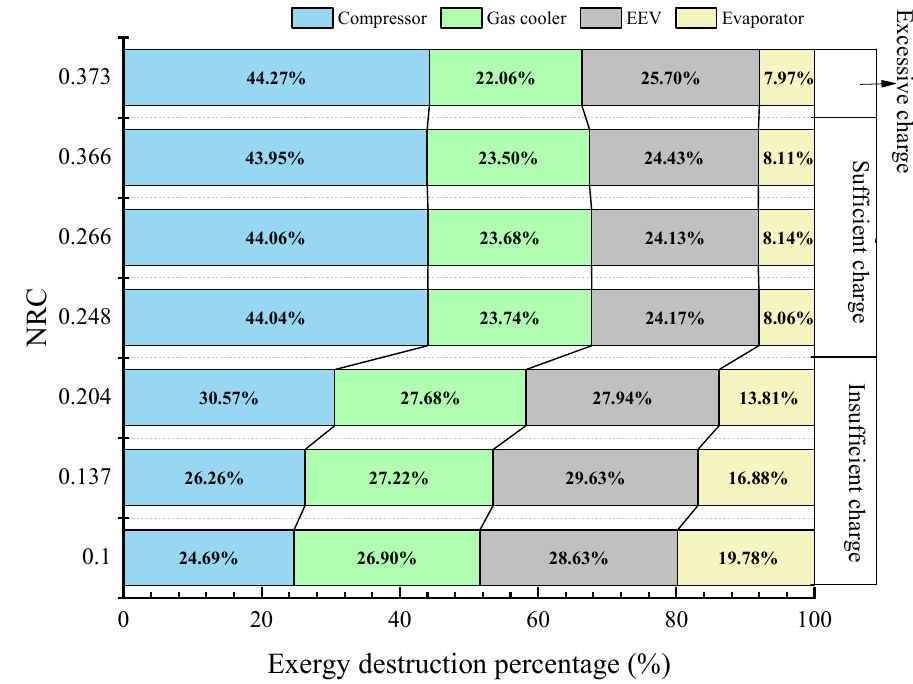
Figure 8. Variation of exergy destruction percentage of each component corresponding to the optimal COP with NRC at ambient temperature of 35 °C.